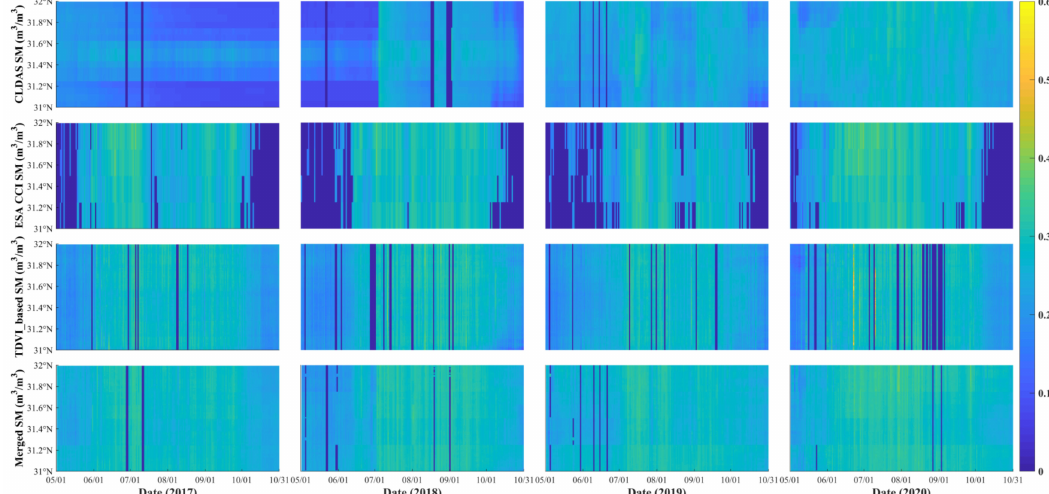
Figure 6. Hovmöller (time-latitude) diagrams of CLDAS, ESA CCI combined, TDVI-based, and merged SM products for the study period (every May to October from 2017 to 2020).